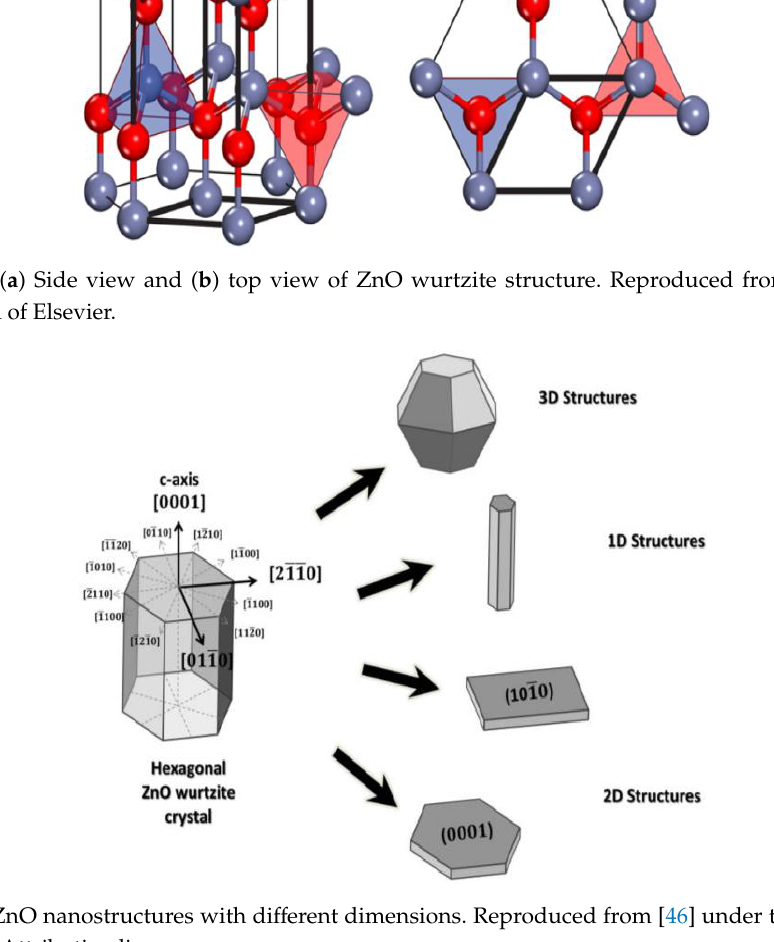
Figure 4. ZnO nanostructures with different dimensions. Reproduced from [46] under the Creative Commons Attribution license.